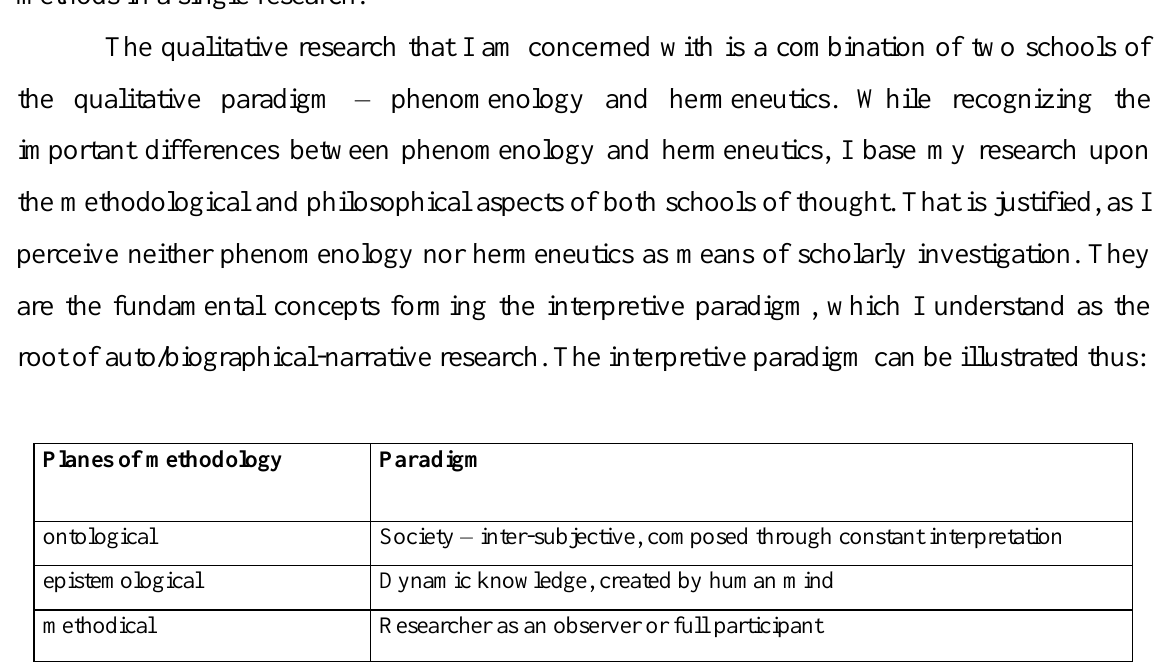
Fig. 4. Interpretive paradigm; source: Malewski 1997, Malewski 1998, author’s compilation Addressing the various contexts of methodology (ontological, epistemological, methodical), as proposed by M. Malewski, I shall describe the nature of qualitative